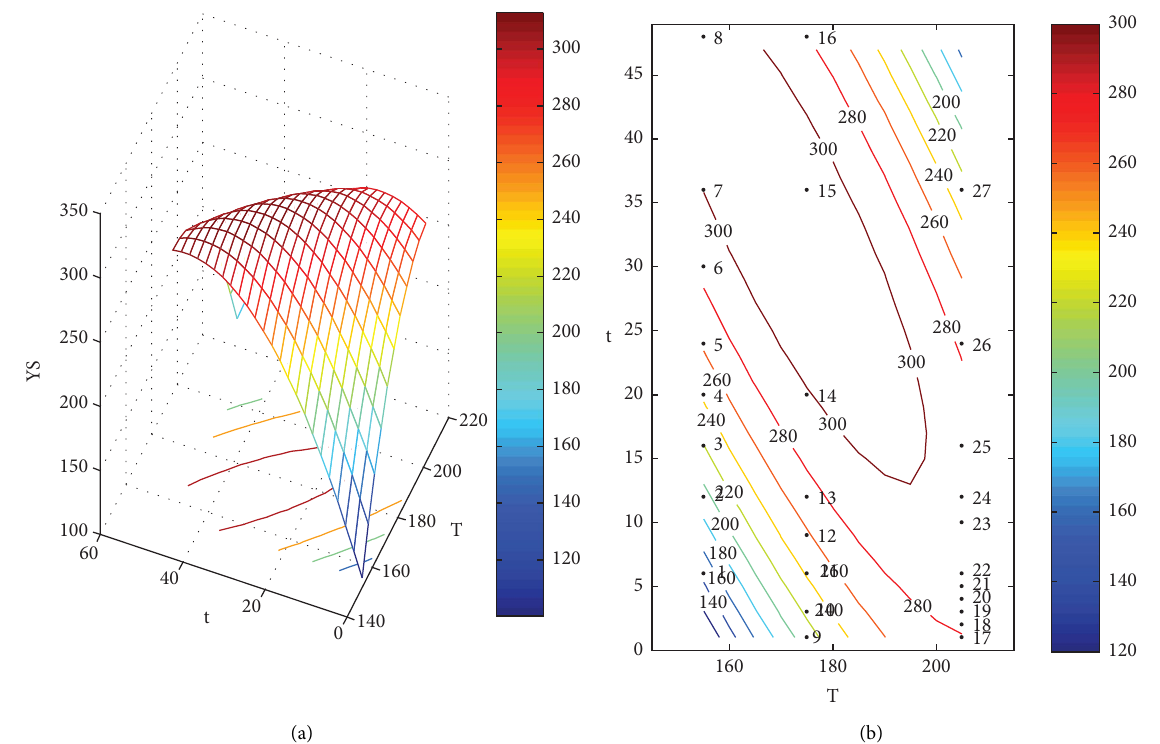
Figure 1: 3D surface graph of the regression model (a) and quality map (b) for YS of cast aluminum alloy A357 according to artifcial aging heat treatment